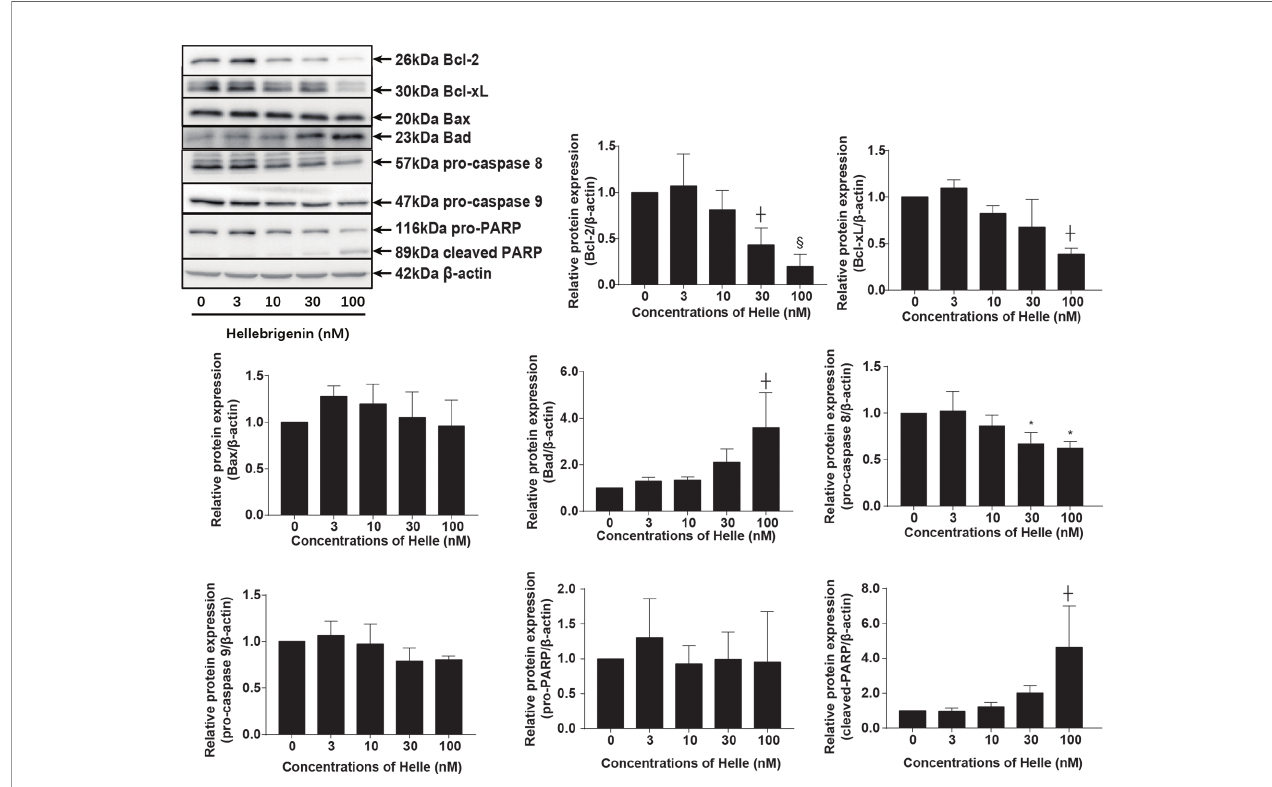
FIGURE 4 | Helle-mediated activation of apoptosis signaling pathway in MCF-7 cells. After treatment with various concentrations of Helle (3, 10, 30 and 100 nM) for 48 h, the expression pro fi le of apoptosis − related proteins was analyzed using western blotting. The relative expression levels were expressed as the ratios between each target gene protein and b -actin protein expression levels, and compared with those of untreated control group, respectively. Data are presented as the means ± SD from three independent experiments. *p < 0.05; ┼ p < 0.01; § p < 0.001 vs.